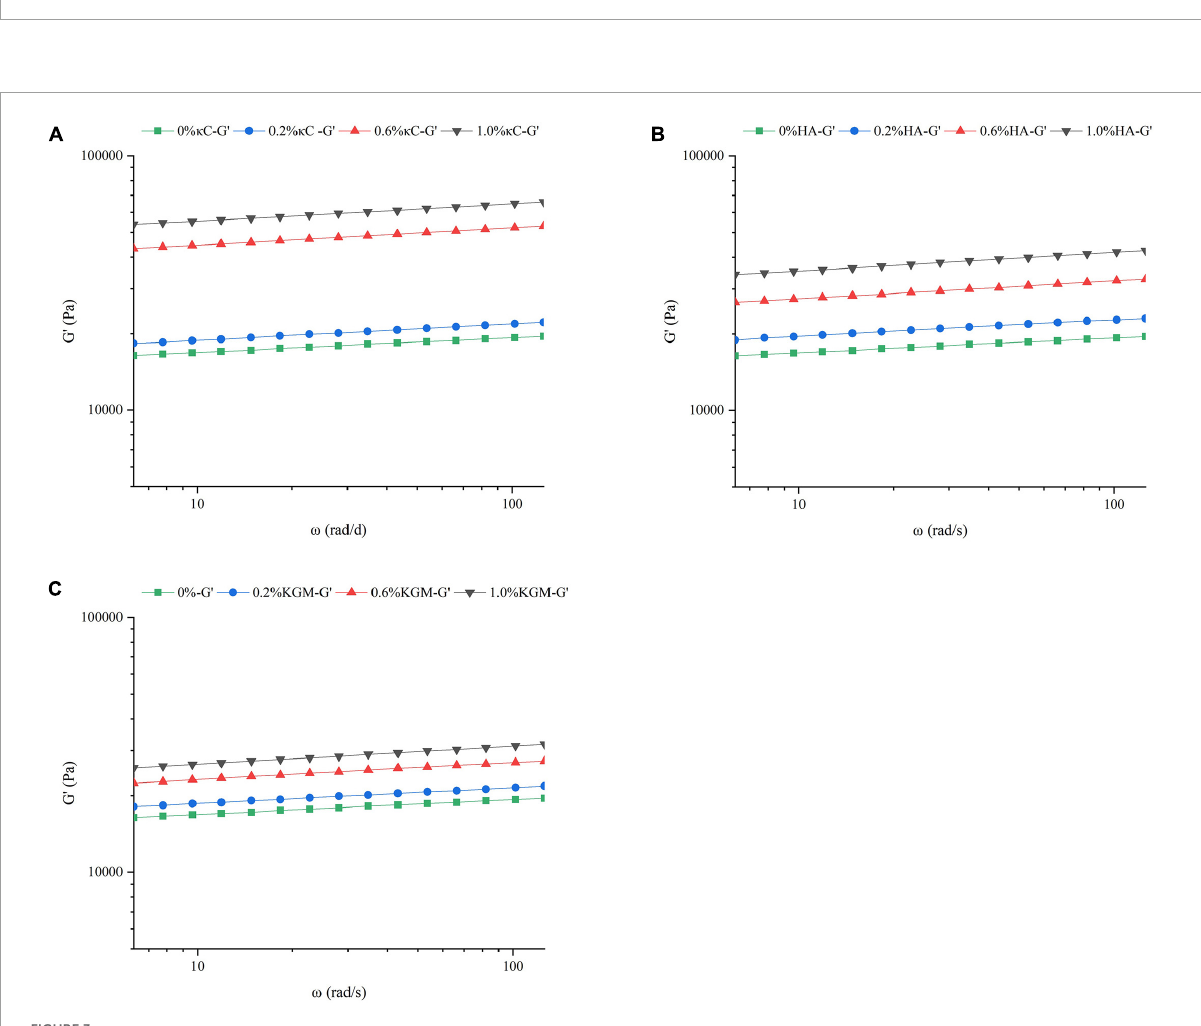
FIGURE2 Final G’ (A) and G” (B) of the emulsion gels containing different polysaccharides. κ C, κ -carrageenan; HA, high-acyl gellan; KGM, konjac glucomannanon.